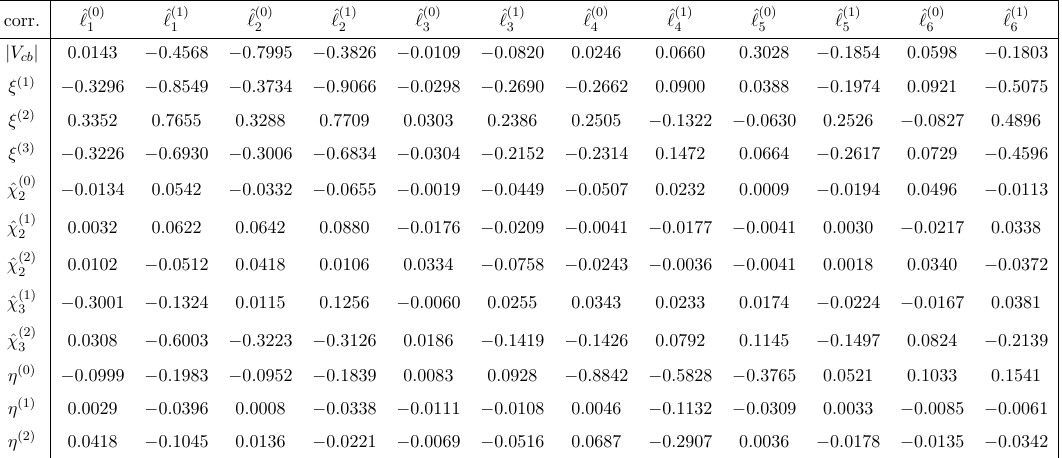
n (cid:24) ( n ) ; ^ (cid:31) ( n )